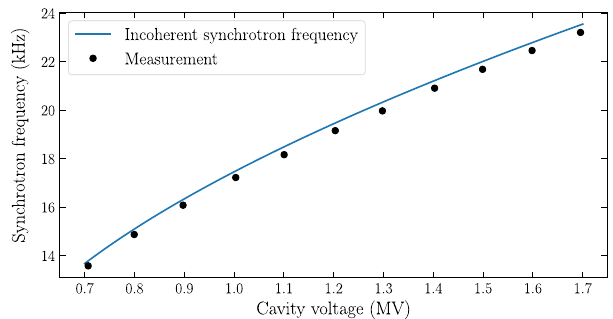
FIG. 17. Measured amplitude of the center-of-bunch beam oscillation as a function of the phase-modulation amplitude. The error bars show fitting errors. The dotted line shows the linear fit between the oscillation amplitude and modulation amplitude.